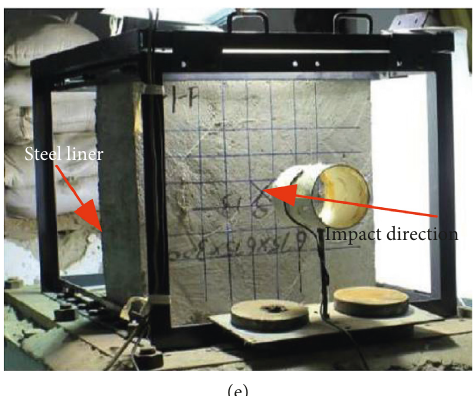
Figure 4: Experimental layout and the research object of each target [30]. (a) 100+100 +100(1). (b) 200+ 100(1). (c) 150+150(1). (d) 100+200(1). (e) 300(1).